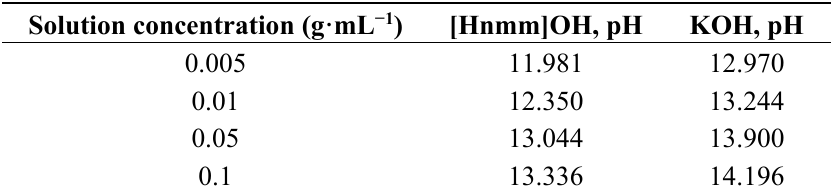
Table 1. Alkalinity of [Hnmm]OH.